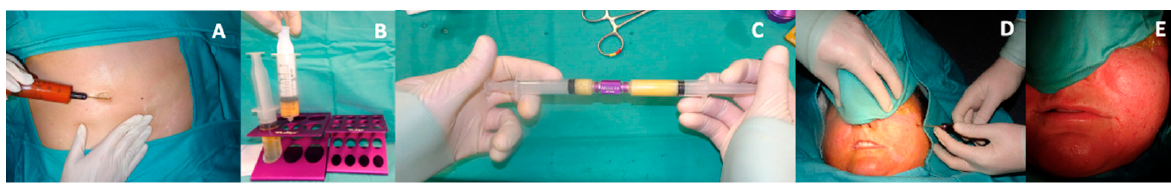
Figure 2. Surgical marking and entry points (indicated as pentagrams) of procedure.